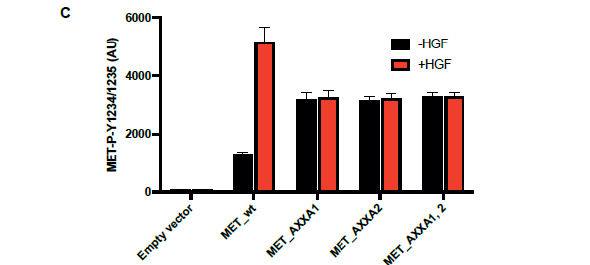
Figure 5. The MET CXXC mutants are constitutively phosphorylated. ( A ) TOV112D cells stably expressing indicated receptors were treated with ± 50 ng/ml HGF for 15 min and stained with MET-P-Y1234/1235 antibodies (cyan pseudocolor) and 58 K Golgi protein antibodies (yellow pseudocolor). DAPI staining was performed to visualize the nuclei (grey). Images were acquired with the Leica TCS SP8 confocal microscope and post-processed with ImageJ. Pictures are representative of two independent experiments. Arrows in the merged images denote Golgi gathering of the P-MET signal. ( B , C ) Stable TOV112D clones expressing either MET_wt or the indicated mutant forms of MET were serum-starved for 24 h and treated with 50 ng/ml of HGF for 15’. Proteins were resolved in 6% SDS-PAGE and MET expression, and MET-P-Y1234/1235 levels were assessed by Western blot ( B ), and the amount of MET-P-Y1234/1235 was quantified by flow cytometry in permeabilized cells ( C ). Results are mean +/ − SEM with N = 3.